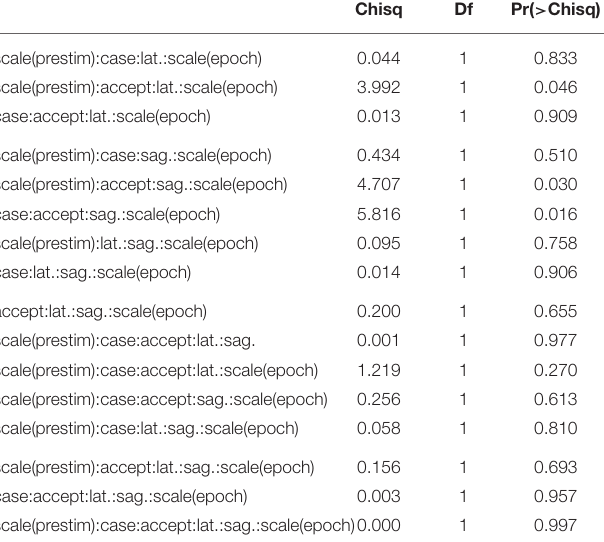
TABLE 4 | Summary of experiencer verb analysis including acceptability effects in N400 time window (Type II Wald Tests).